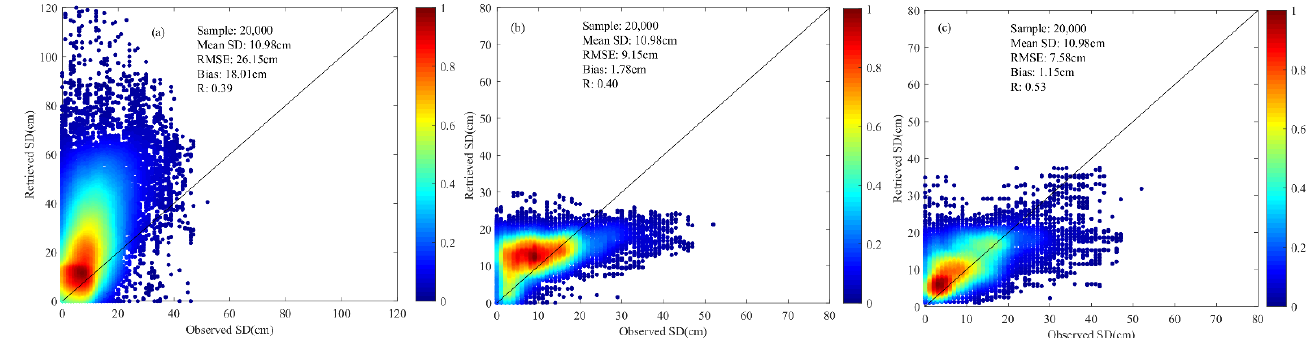
Figure 6. The color–density scatterplots of the retrieved SD and the observed SD at ground meteorological stations. ( a – c ) represent raw AMSR2 SD product, the downscaled SD based on general SD downscaling model, and the downscaled SD based on multifactor SD downscaling model, respectively. Table 3. Error statistics for the comparison between retrieved SD and observed SD in this study.